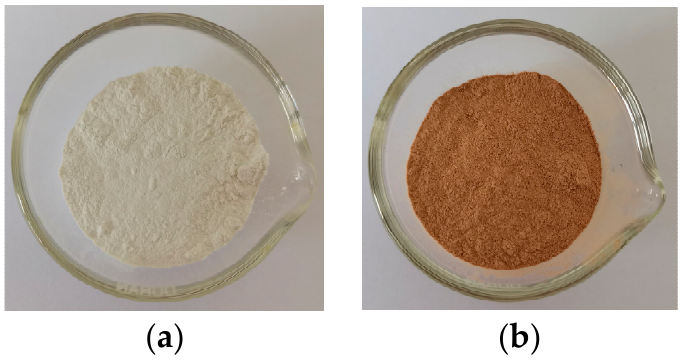
Figure 1. Images of ( a ) CEM and ( b ) VSW samples.